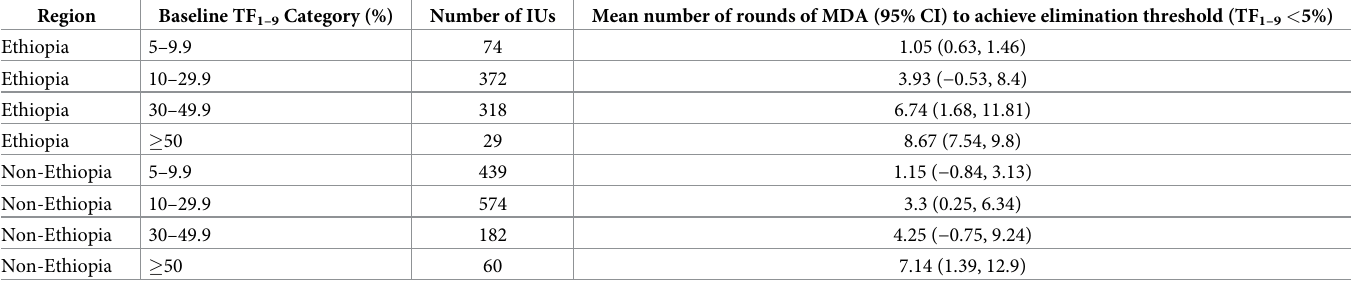
Table 3. Mean number of rounds (95% CI) to achieve elimination threshold (TF 1–9 < 5%) by Ethiopia/non-Ethiopia and baseline category. Region